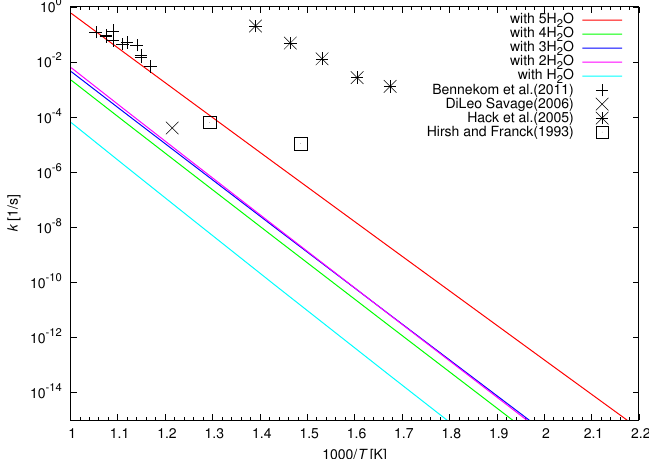
Figure 10. Rate constants for the oxidation of a CH that calculated in this study. The rate constant is calculated when the oxidation is catalyzed by up to four H O molecules in a ring structure or by a cluster of five H 2